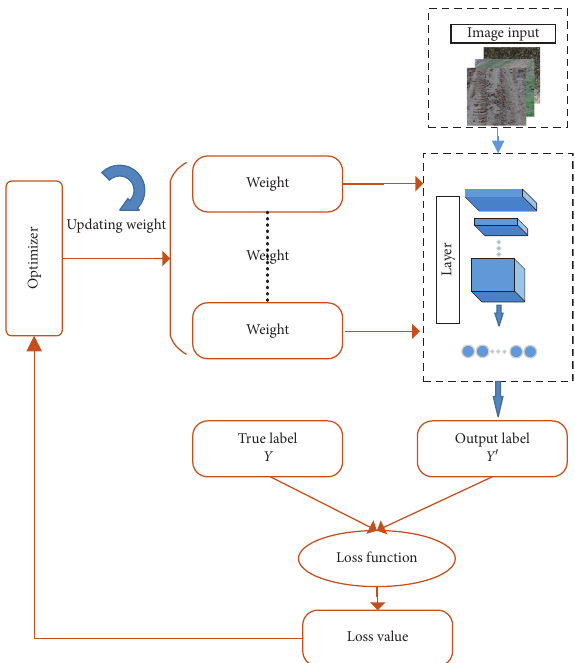
Figure 1: The training process of road surface image based on deep